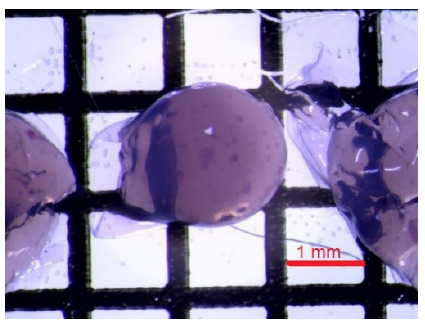
Figure 8. HFBMA NPs in a chitosan hydrogel bead.